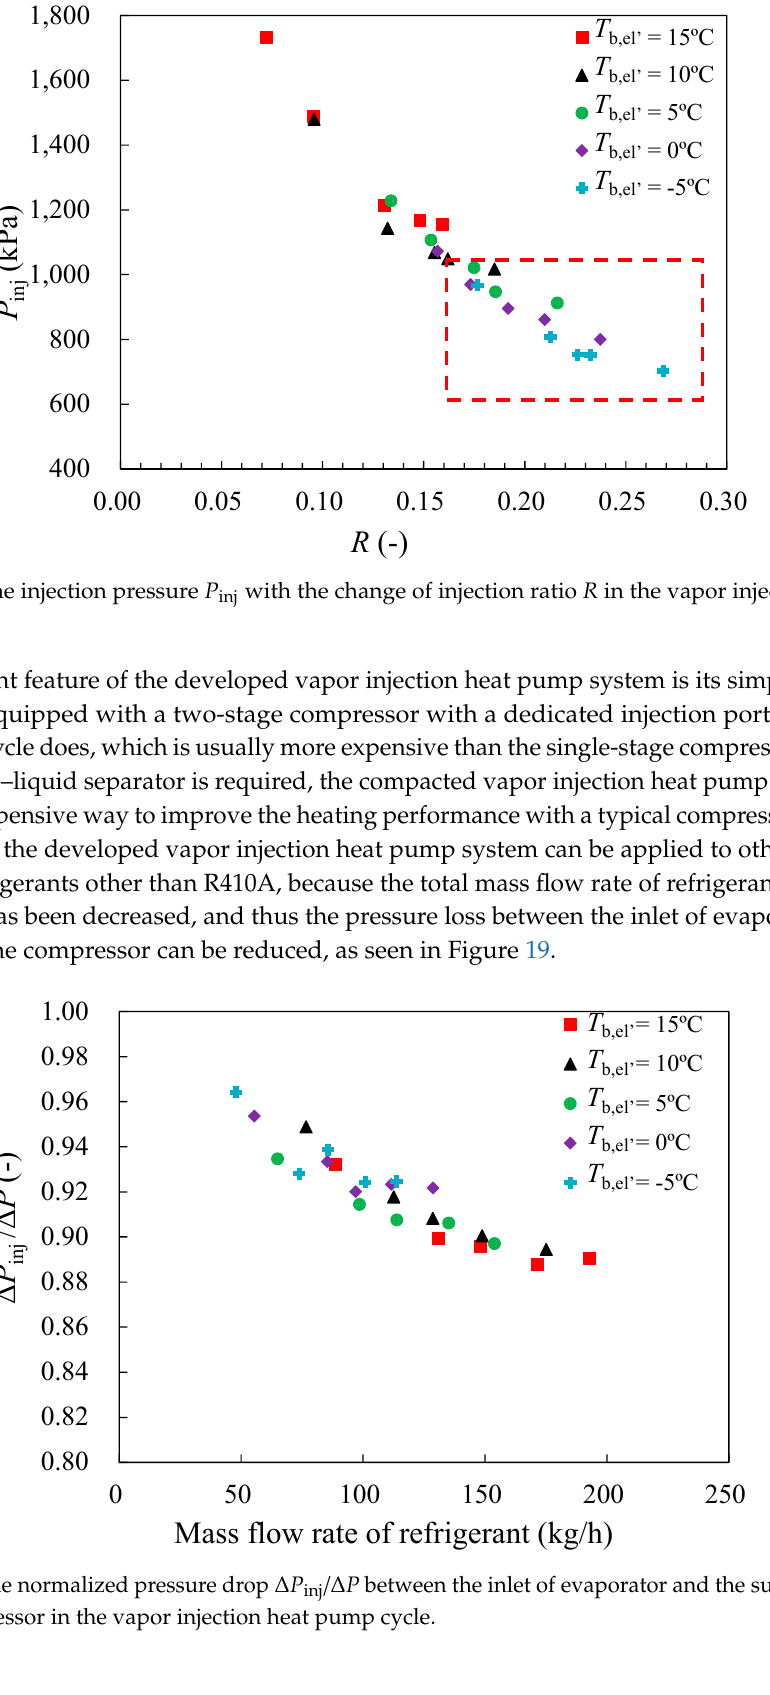
Figure 19. The normalized pressure drop ∆ P inj / ∆ P between the inlet of evaporator and the suction port of the compressor in the vapor injection heat pump cycle.